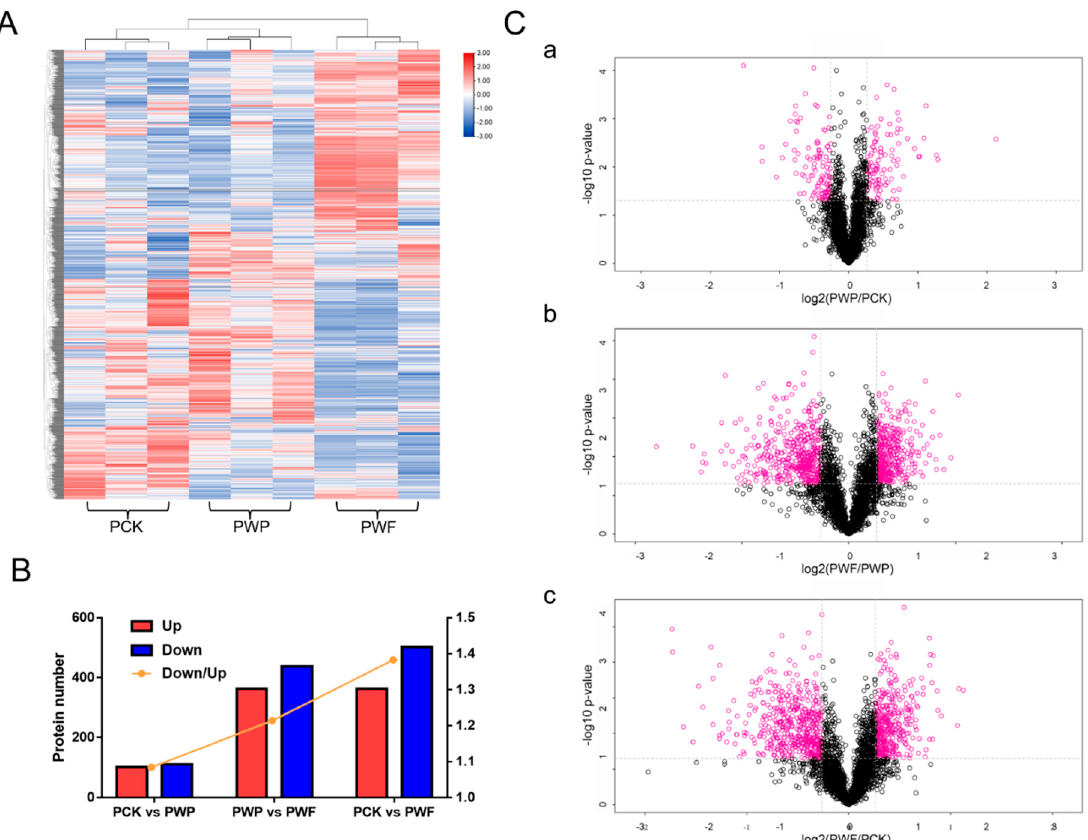
Figure 3. Overview of differentially expressed proteins (DPs). ( A ) Heat map of the types and contents of volatiles detected in different time periods. ( B ) Column chart showing DPs and the ratio of downregulated DPs to upregulated DPs (down/up). ( C ) The volcanic map was drawn by using the fold change in DPs between the two groups of samples (including a. PCK vs. PWP, b. PWP vs. PWF, c. PCK vs. PWF) and the p -value obtained by t -test, which was used to show the significant difference between the two groups. The abscissa is the change fold (logarithmic transformation with base 2), the ordinate is a significant p -value (logarithmic transformation with base 10), red dots represent proteins with significant difference (fold change was more than 1.2-fold and p -value < 0.05), black dots represent proteins with no difference. PCK, PWP, and PWF represent proteomic samples with withering times of 0 h, 12 h, and 30 h,